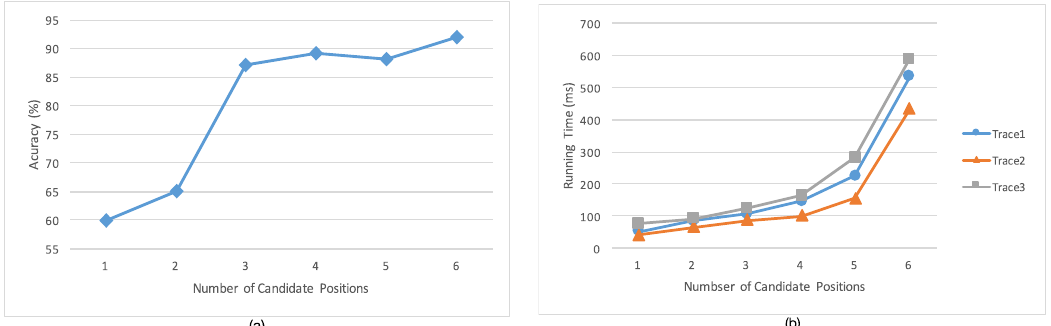
Figure 8. ( a ) Accuracy w.r.t. number of candidate positions; and ( b ) Running time w.r.t. number of candidate positions.